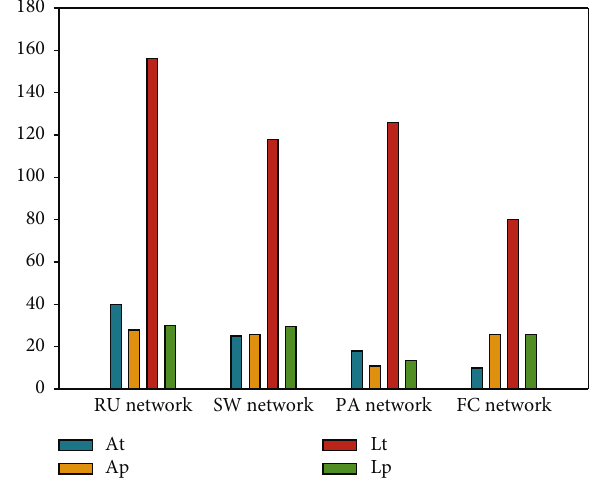
Figure 6: Final performance level and equilibrium time assessors and